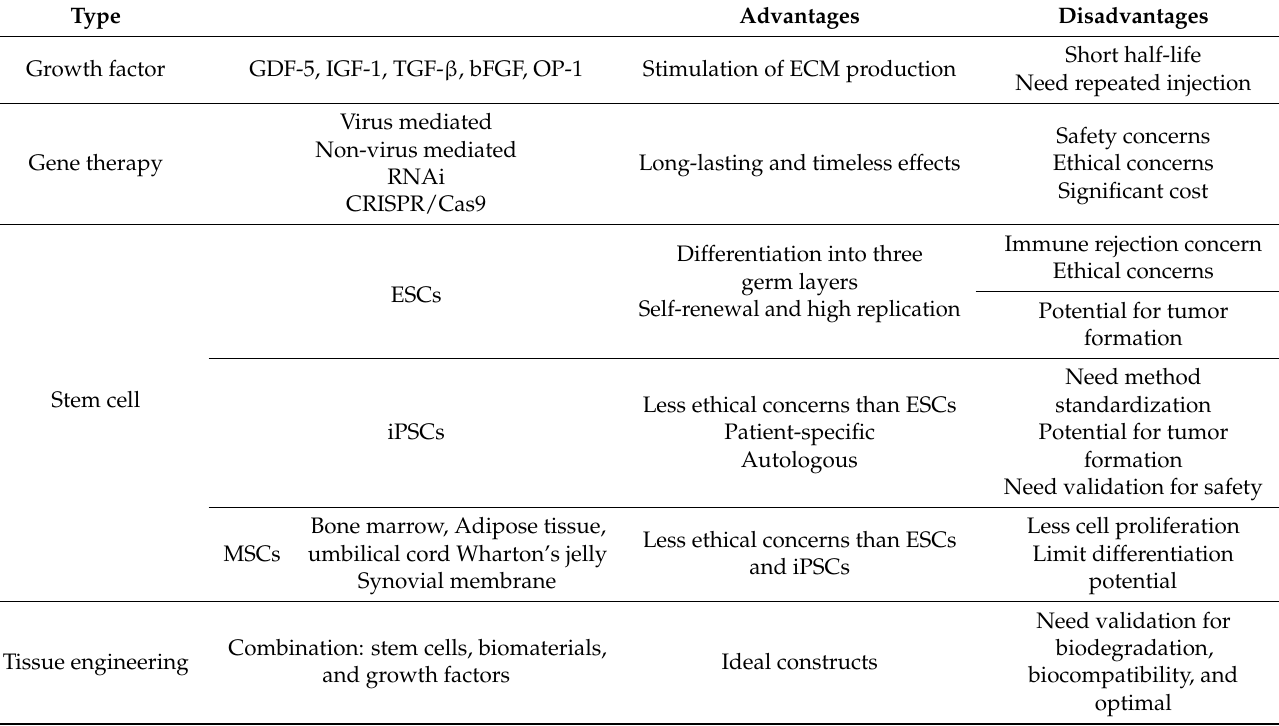
Table 3. Type of regenerative therapies for intervertebral disc